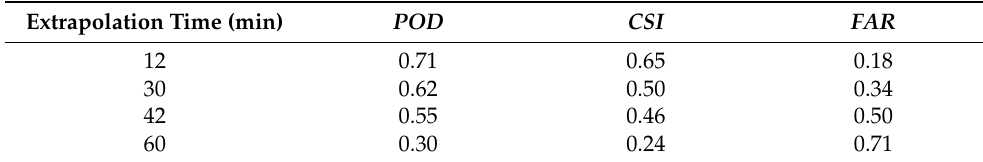
Table 5. TITAN algorithm extrapolation results at the threshold of 30 dBZ.